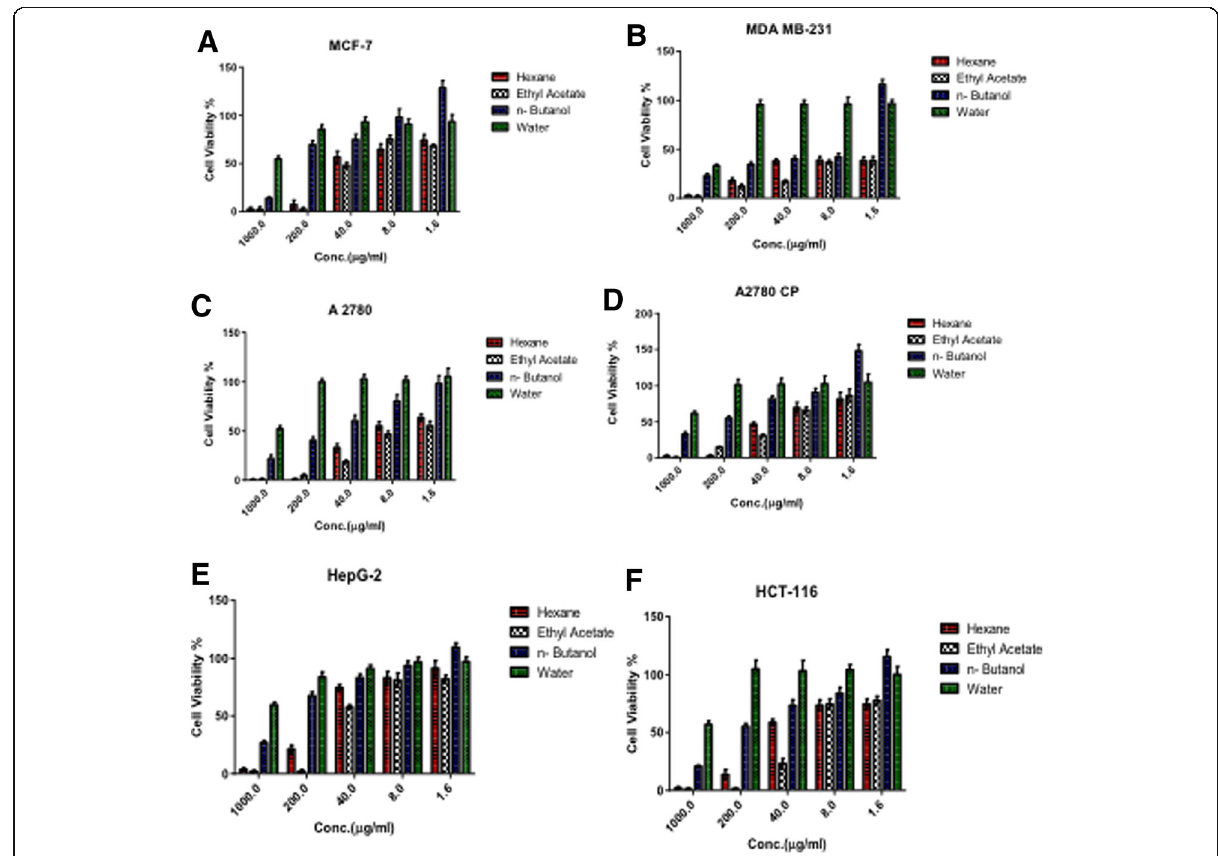
Fig. 3 Inhibitory effects of n-hexane, ethyl acetate, n-butanol and aqueous fractions on proliferation of cancer cells ( a -MCF-7; b -MDA-MB-231; c -A2780; d -A2780CP; e -HepG2 and f -HCT-116). Cells were treated with 0-1000 µg/ml of each fraction. MTT assay was used to measure the cell viability % after 48 hrs of treatment. The error bars indicate SD of n = 8 per